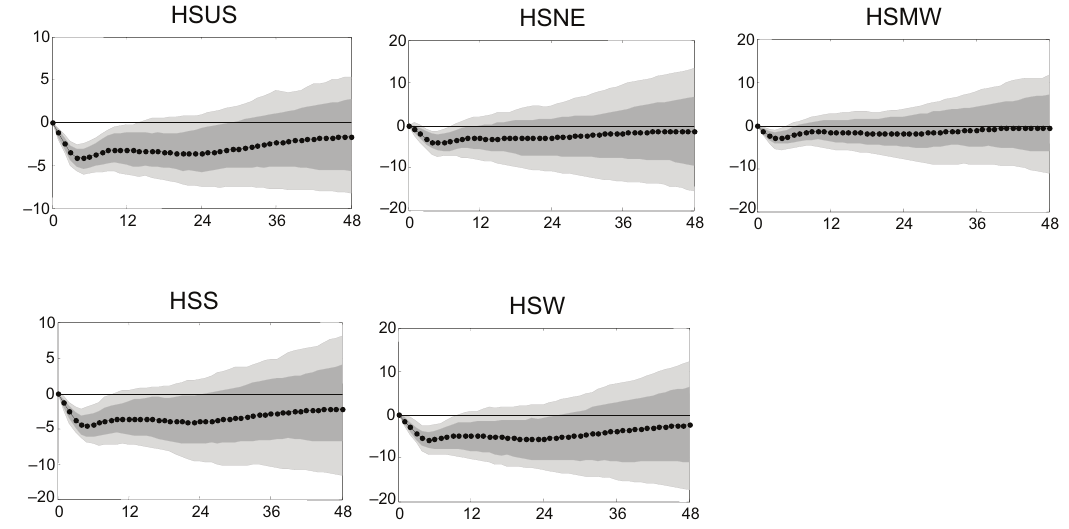
Figure 8. effect of 100-basis-point monetary policy shock on housing